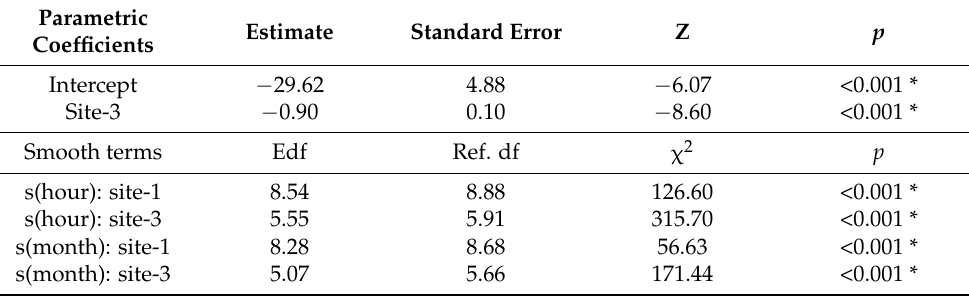
Table 2. The table below summarizes a negative binomial GAM model that was used to examine the effect of recording time and month on C. saturatus ’s activity. The recording hour and month were modeled independently with smoothed function for each monitored site, while the cyclic predictor was modeled using a cyclic cubic regression spline. Reference degrees of freedom was used to calculate test statistics and p -values are represented by Ref. df whereas Edf (Effective degrees of freedom) indicates the curviness of the relationship.